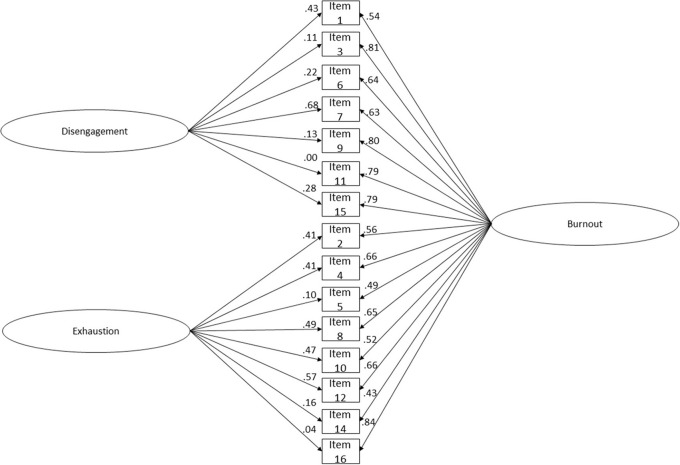
OLBI's bi-factor reduced version (15 items) structure fit. A combined sample of Portuguese (n = 268) and Brazilian (n = 318) workers. Latent loadings for each factor; and factor loadings for each item are shown. χ(75)2 = 392.202; p < 0.001; n = 586; CFI = 0.990; CFIscaled = 0.937; NFI = 0.987; TLI = 0.986; SRMR = 0.056; RMSEA = 0.085; P(rmsea ≤ 0.05) < 0.001; 90% CI ]0.077; 0.093[.